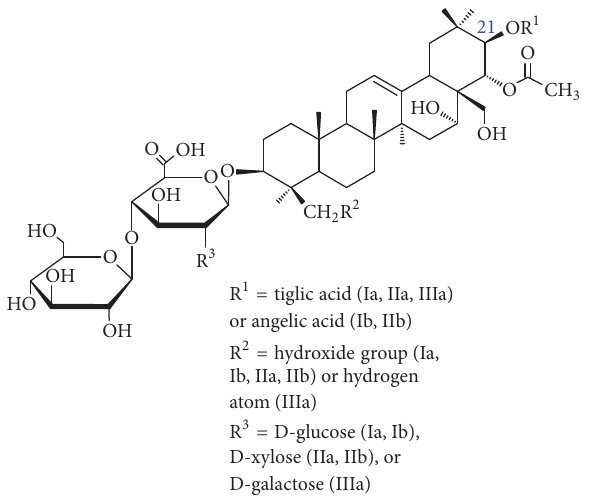
Figure 1: The schematic model of 𝛽 -escin molecule.